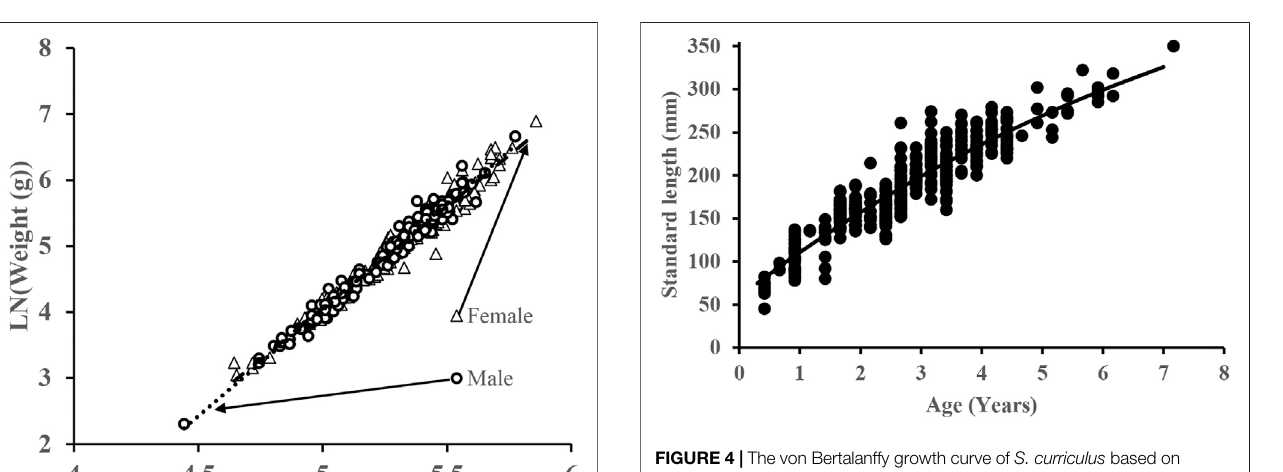
FIGURE 4 | The von Bertalanffy growth curve of S. curriculus based on the observedstandardlength atage inthewesternPearl River estuary, China.